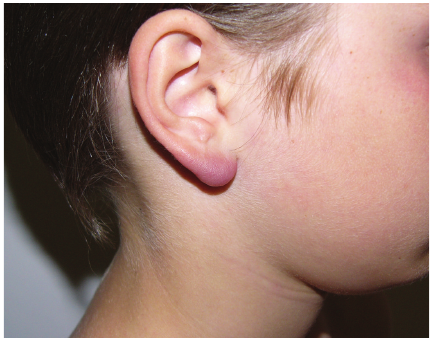
Figure 3: Lymphadenosis benigna cutis.